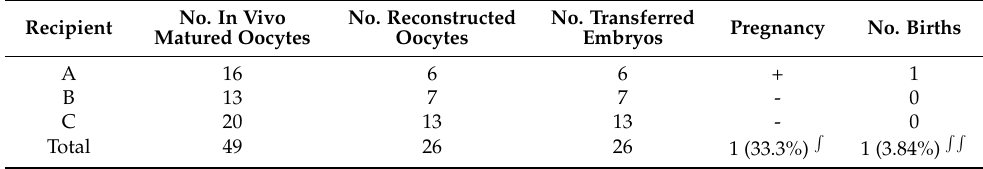
Table 1. Summary of embryo transfer and generation of the dystrophin mutant cloned pup.